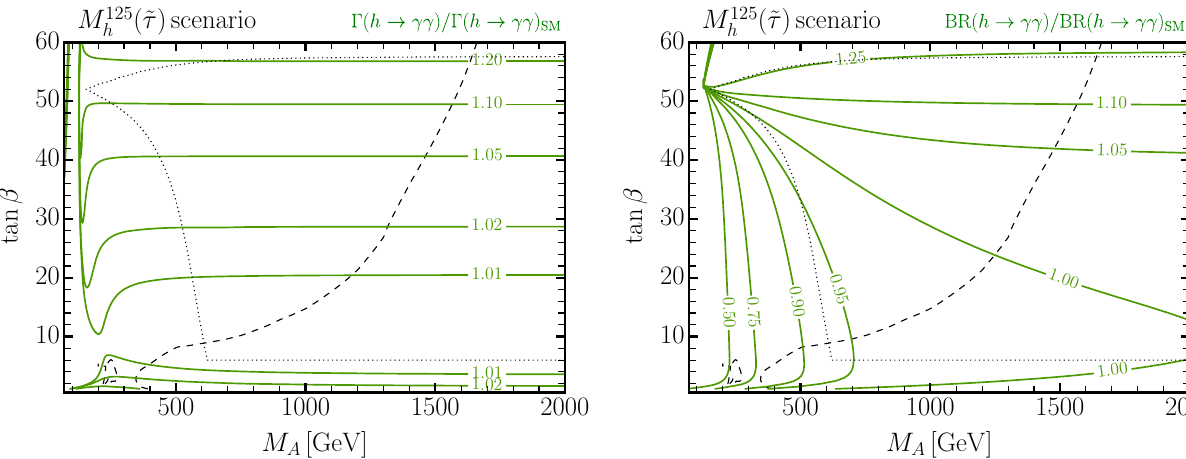
Fig. 3 Left: Decay width of the lighter CP -even scalar into photons each plot, the boundaries of the blue and the hatched exclusion regions ( ˜ τ) scenario, normalized to as a function of M A and tan β in the M 125 of Fig.2 are also shown as a dashed and a dotted black line, respectively h the corresponding width of a SM Higgs boson of the same mass. Right: same as the left plot for the branching ratio of the decay h → γγ . In